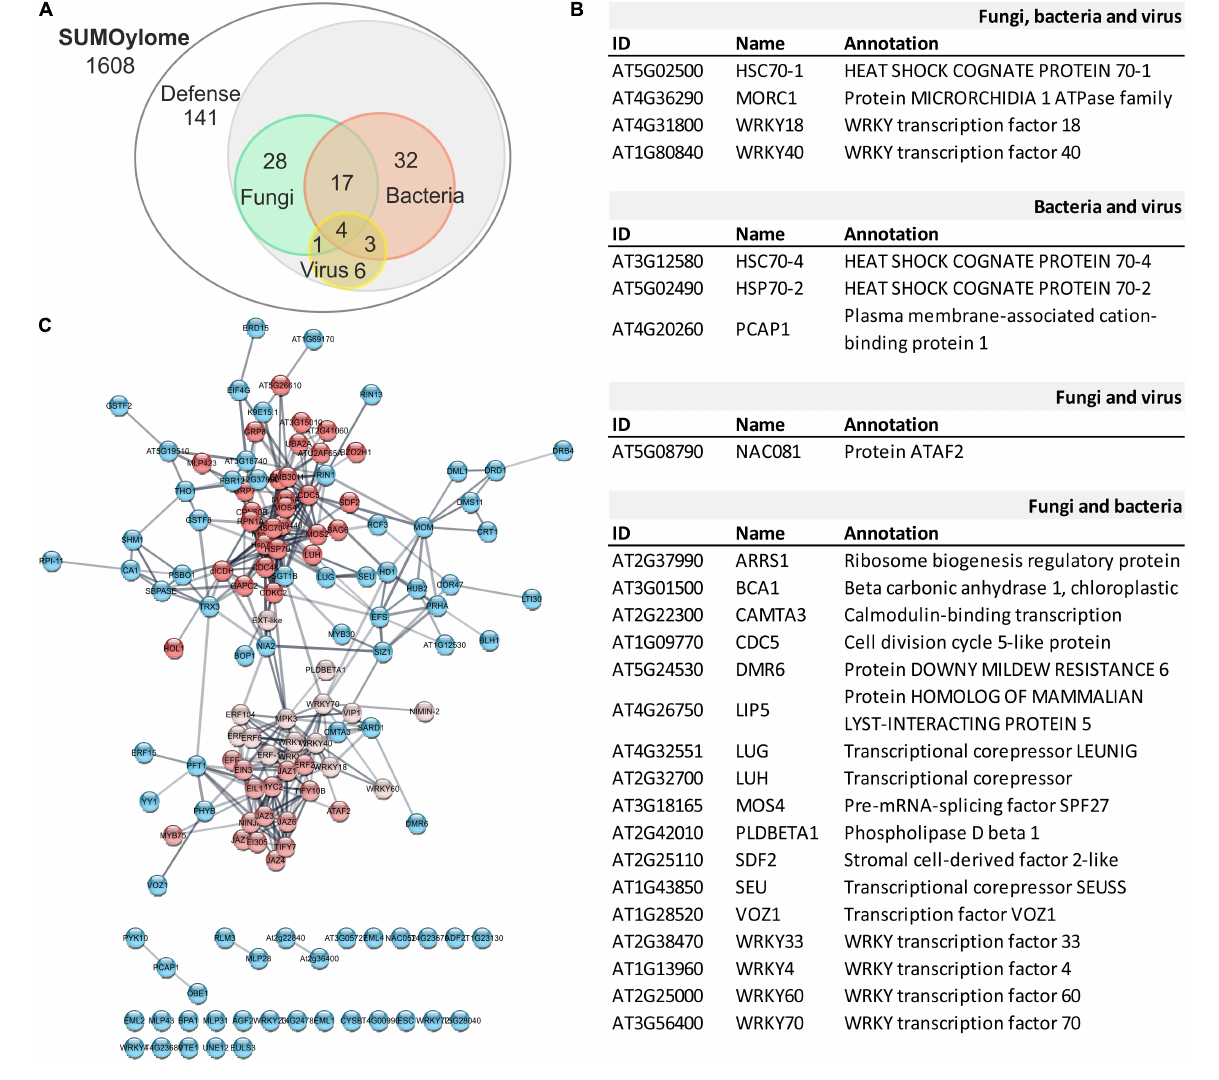
FIGURE 3 | Network Analysis of the defense SUMOylome. (A) Venn diagram showing distribution of potential SUMO targets with a role in defense (141) responses to pathogenic fungi (28), bacteria (32), or virus (6). The proteins involve in defense responses against multiple pathogens are indicated at the intersections. (B) List of proteins included in the indicated intersections. (C) Interaction network analysis of the 141 proteins with a role in defense responses. The functional association obtained using the STRING web server was analyzed according to MCL cluster algorithm (Cytoscape). The three protein interaction clusters identified are indicated by different shades of